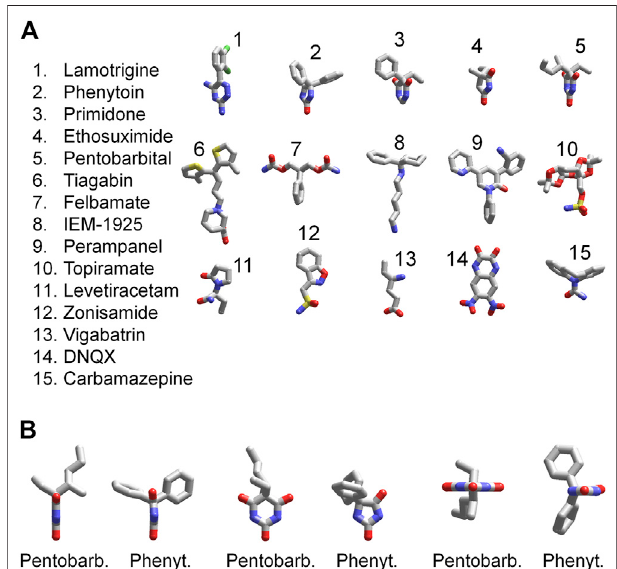
FIGURE 11 | 3D structures of compounds. (A) Comparison of 3D structures of the compounds. The structures demonstrate large diversity, although compounds 1 – 5 have certain similarity; they have a heterocycle shown in the bottom and aromatic/hydrophobic moieties shown in the top. (B) Comparison of 3D structures of phenytoin and pentobarbital in different orientations. The 3D structures demonstrate close similarity of orientation of functional